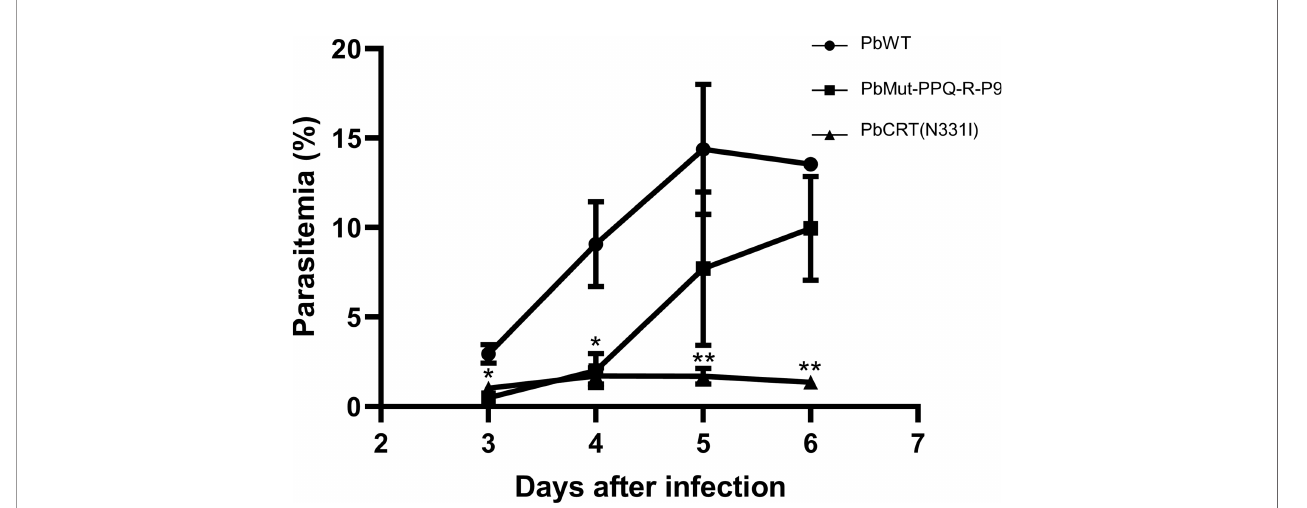
FIGURE 5 | Comparison of growth rates among PbCRT-N331I, PbMut-PPQ-R-P9 and PbWT parasites. Three clones of PbCRT-N331I (closed triangle) and PbMut- PPQ-R-P9 (closed square) were inoculated into one mouse each. PbWT (closed circle) was inoculated into three mice. Parasitemia was monitored from days 3 to 6 after infection. On days 3 and 4, the parasitemia of PbCRT-N331I and PbMut-PPQ-R-P9 was signi fi cantly lower than that of PbWT (p <0.05, indicated by a single asterisk). On days 5 and 6, the parasitemia of the PbCRT-N331I parasite was signi fi cantly lower than that of PbMut-PPQ-R-P9 and PbWT (p <0.05, indicated by double asterisks). The bar represents the standard